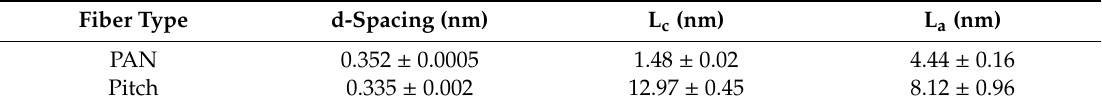
Table 1. Summary of crystalline structures and orientation from X-ray scattering.